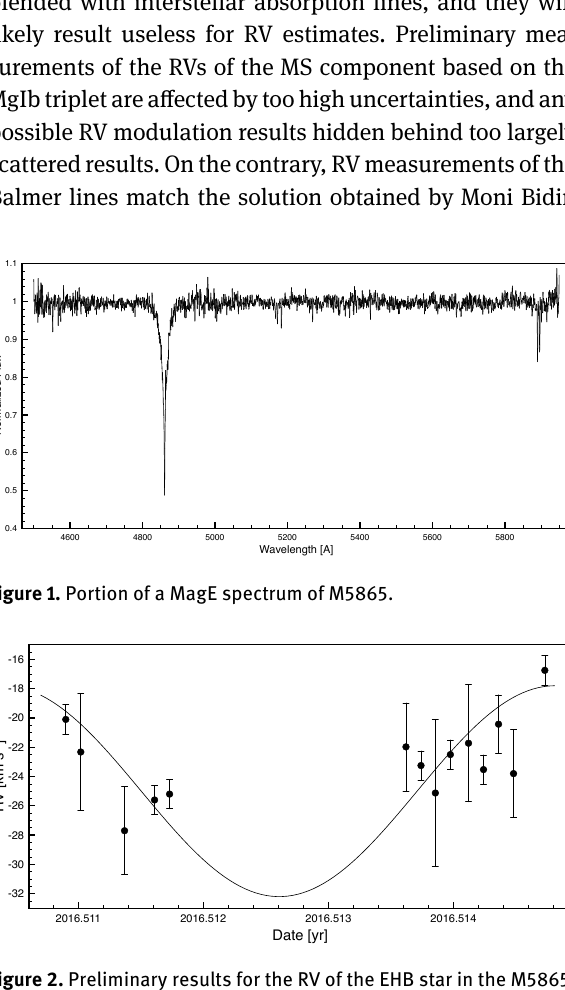
Figure 2. Preliminary results for the RV of the EHB star in the M5865 system. The curve indicates the solution found by Moni Bidin et al.